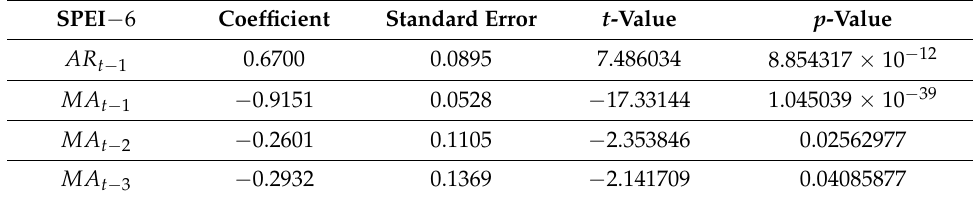
Table 9. SPEI-6 ARIMA (1,1,1)(0,0,2) for seasonal.